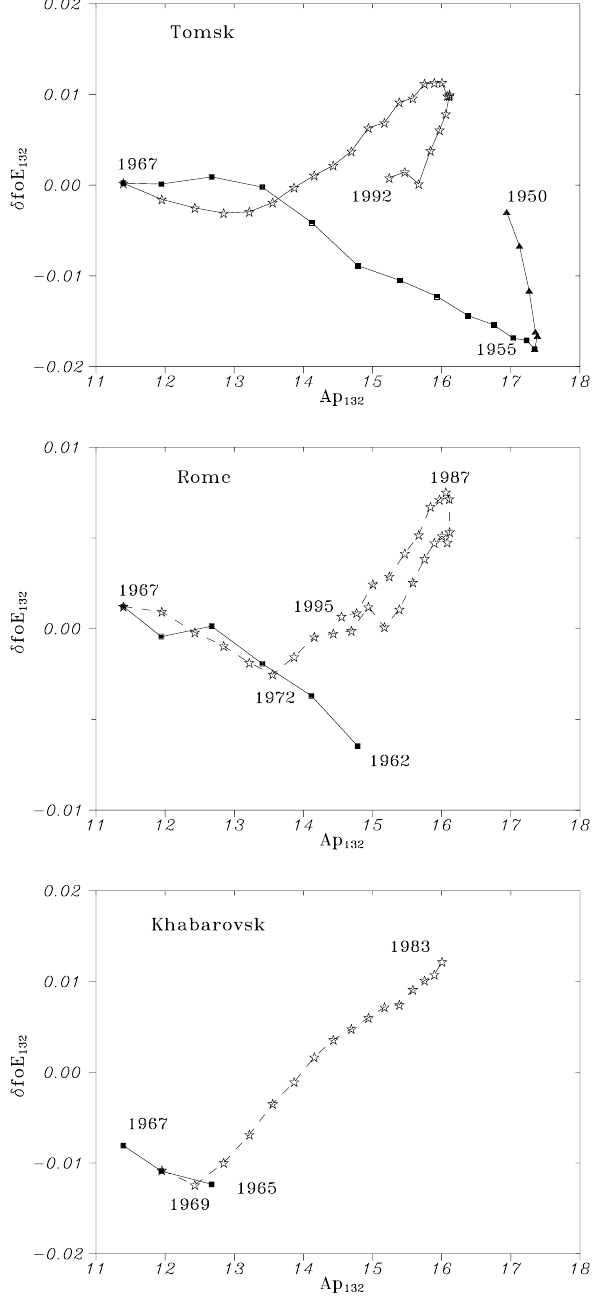
Fig. 2. Relationship between δ fo E 132 and Ap 132 for three stations with a pronounced “break down” effect in this dependence after the end of the